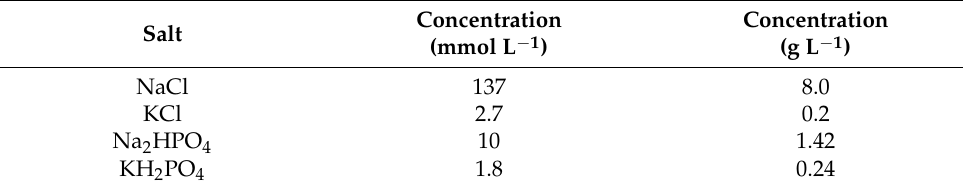
Table 1. The composition of phosphate buffered saline